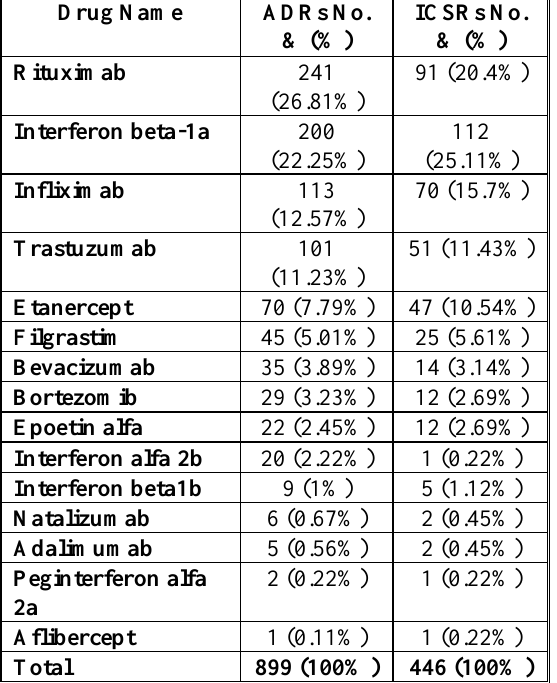
Table 4. ICSRs and ADRs for each of the biological drugs.”